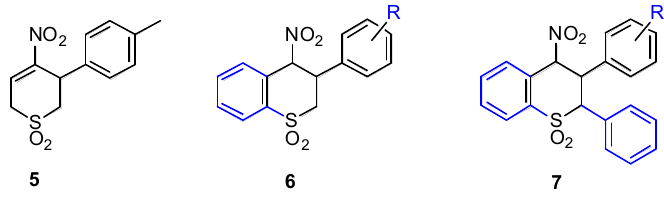
Figure 2. 4-Nitrothiopyran S , S -dioxide 5 and benzocondensed analogues 6 and 7 .